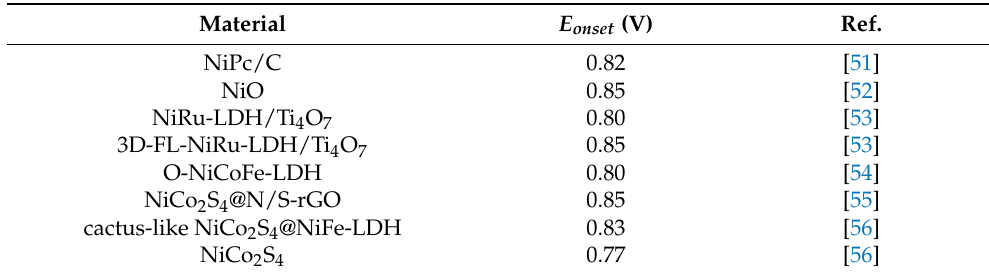
Table 1. The E onset (with respect to RHE) of other nickel-based materials from the literature investi- gated in alkaline solutions.